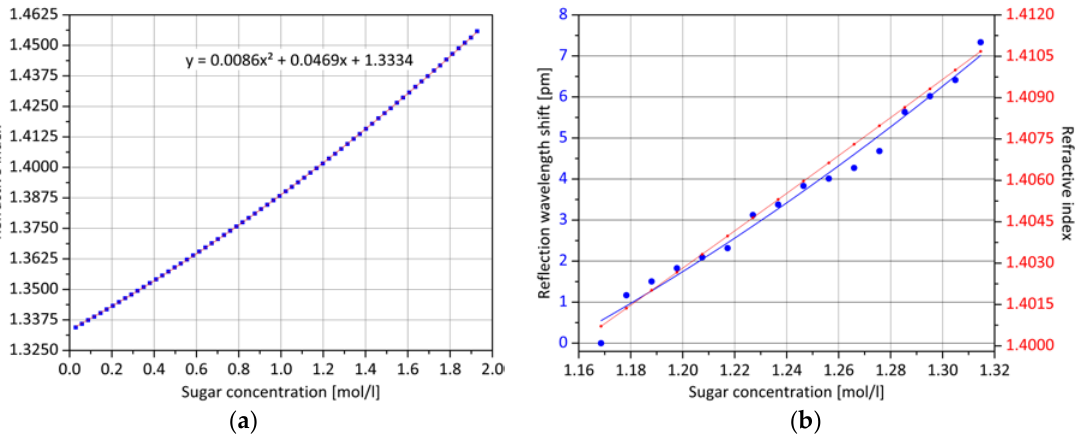
Figure 8. Change in the refractive index of a sugar solution with increasing concentration: ( a ) Using a refractometer, the value curve was measured and approximated in a quadratic equation; ( b ) the red curve shows a section of ( a ). By relative measurement of the Bragg grating wavelength shift, the same concentrations are also detected optically, represented by the blue line. The two shown courses resemble each other fairly well.